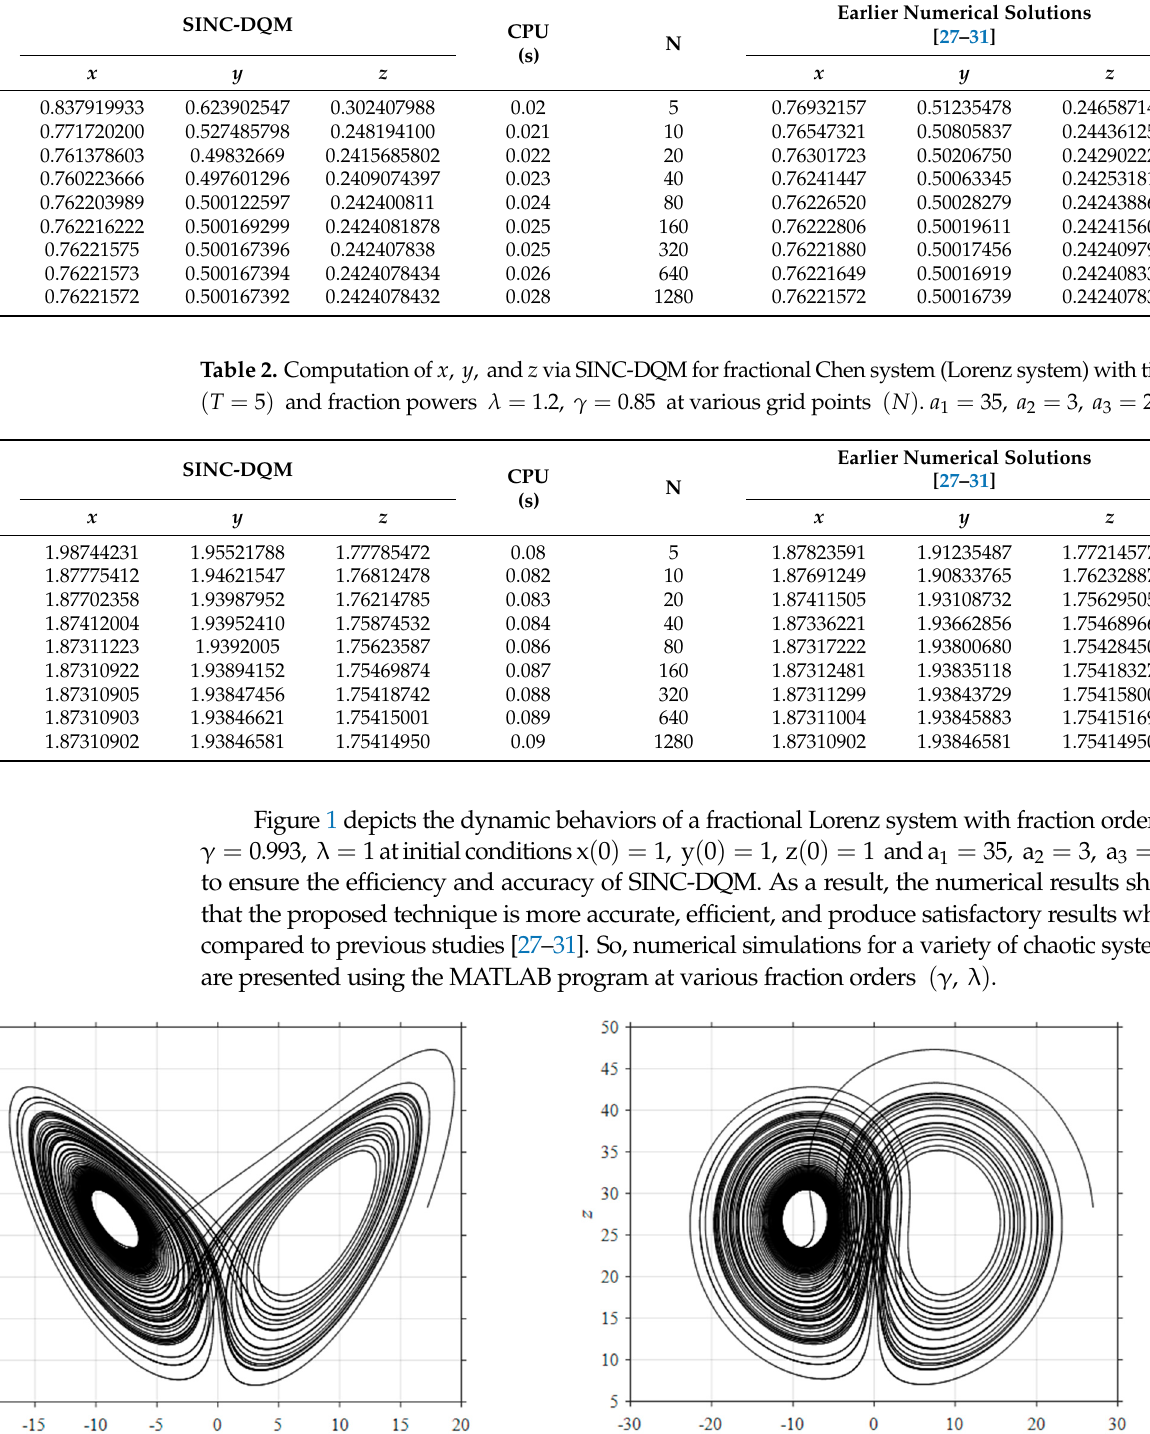
Table 1. Computation of x , y , and z via SINC-DQM for fractional Chen system (Lorenz system) with time ( T = 2 ) and fraction powers λ = γ = 1 at various grid points ( N ) . a 1 = 35, a 2 = 3, a 3 = 28.